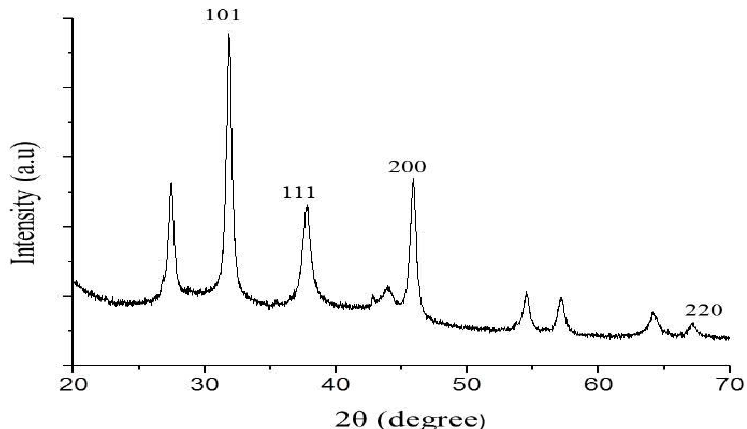
Fig. 2. The image represents the crystalline silver nanoparticles Figure 2: The image represents the crystalline silver nanoparticles